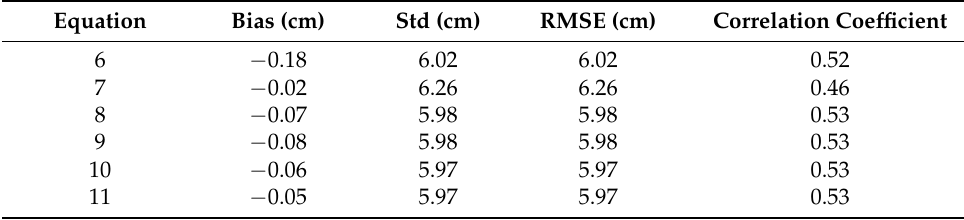
Table 6. Statistics of calibration results on